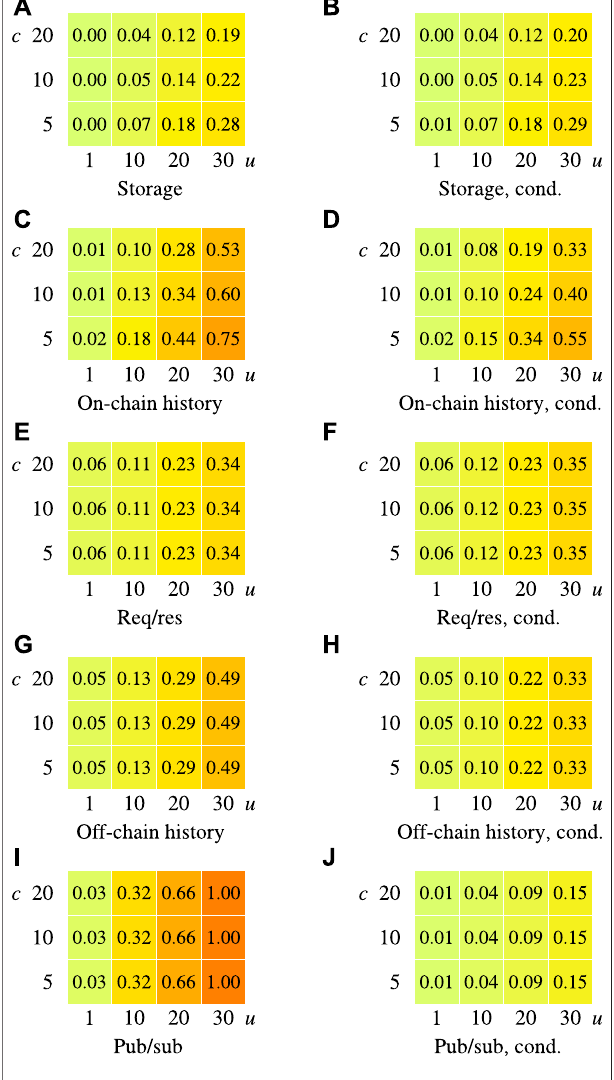
TABLE 4 | Average smart contract deployment